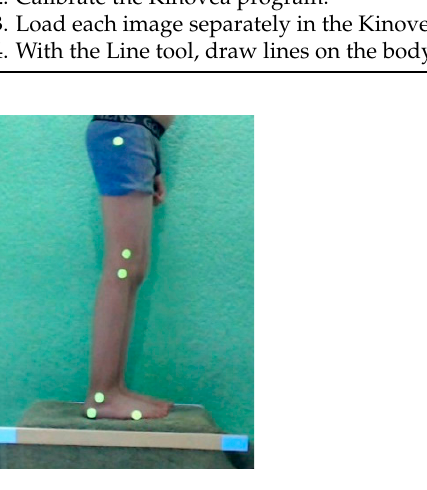
Figure 4. Placing one participant and the element with a known length in the test area.